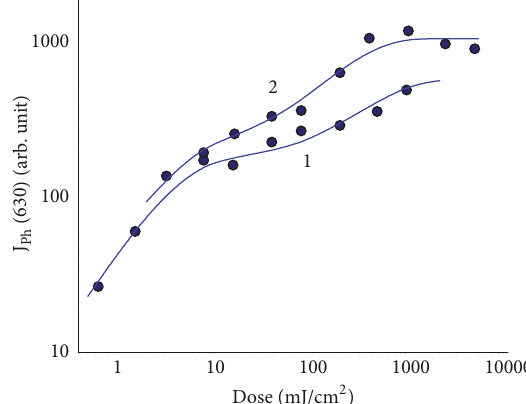
Figure 5: Lux-ampere characteristics of XRL of the ZnSe sample at the irradiation wavelength of 630 nm under various temperatures: 8 K (1) , 85 K (2) , and 295 K (3) .